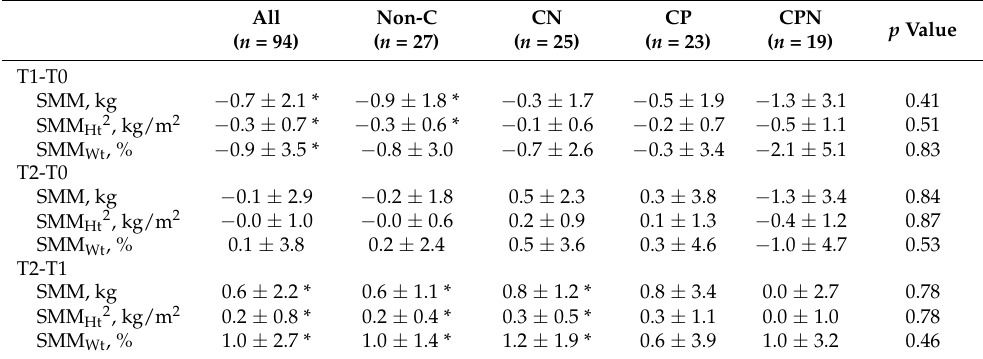
Table 5. Changes in the muscle mass in different nutritional education